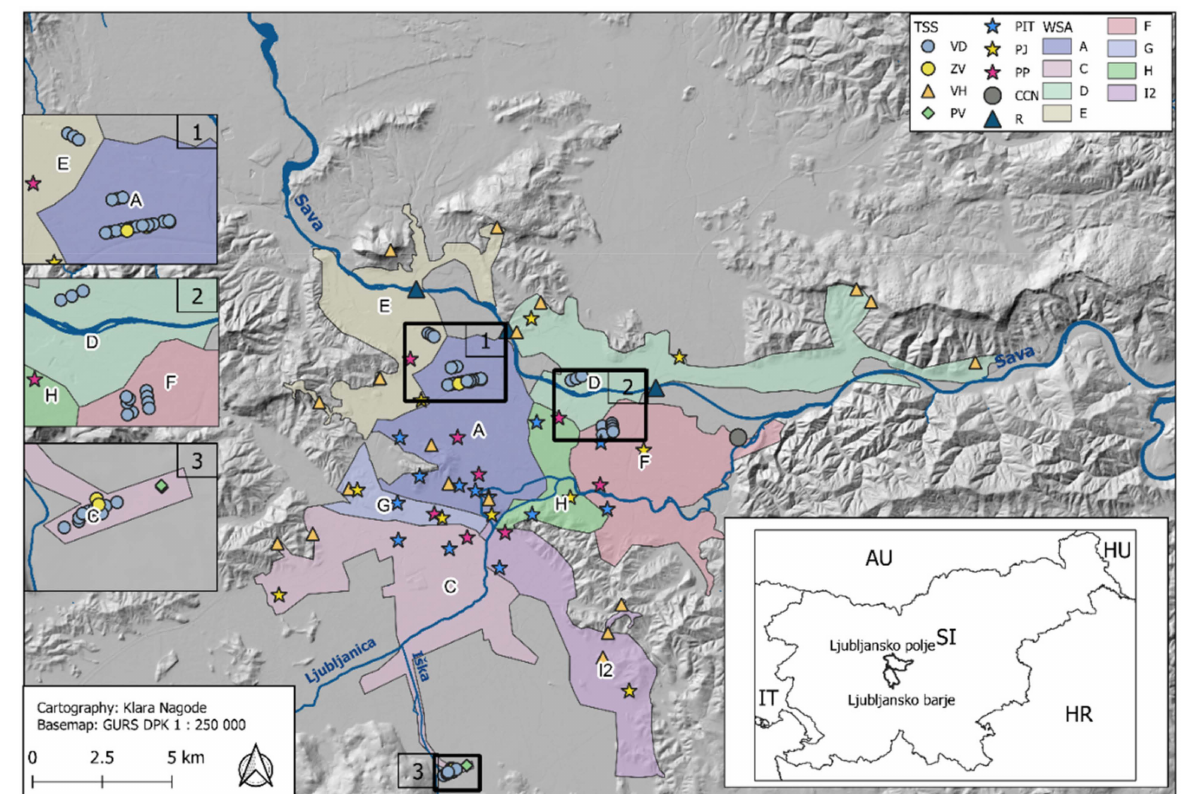
Figure 1. Sampling locations for the different water supply areas (WSA) and type of sampling site (TSS). Zoom locations represent the distribution of wells in the respective wellfields. VD = well, ZV = joint exit from the water pumping station, VH = reservoir, PV = water treatment location, PIT = drinking water fountain, PJ = tap in a public building, PP = tap in a private building, C ˇCN = water treatment plant, R = river; A = Kleˇce, C = Brest, D = Jarški prod, E = Šentvid, F = Hrastje/Jarški prod, G = Kleˇce/Brest, H = Kleˇce/Hrastje/Jarški prod, I2 =